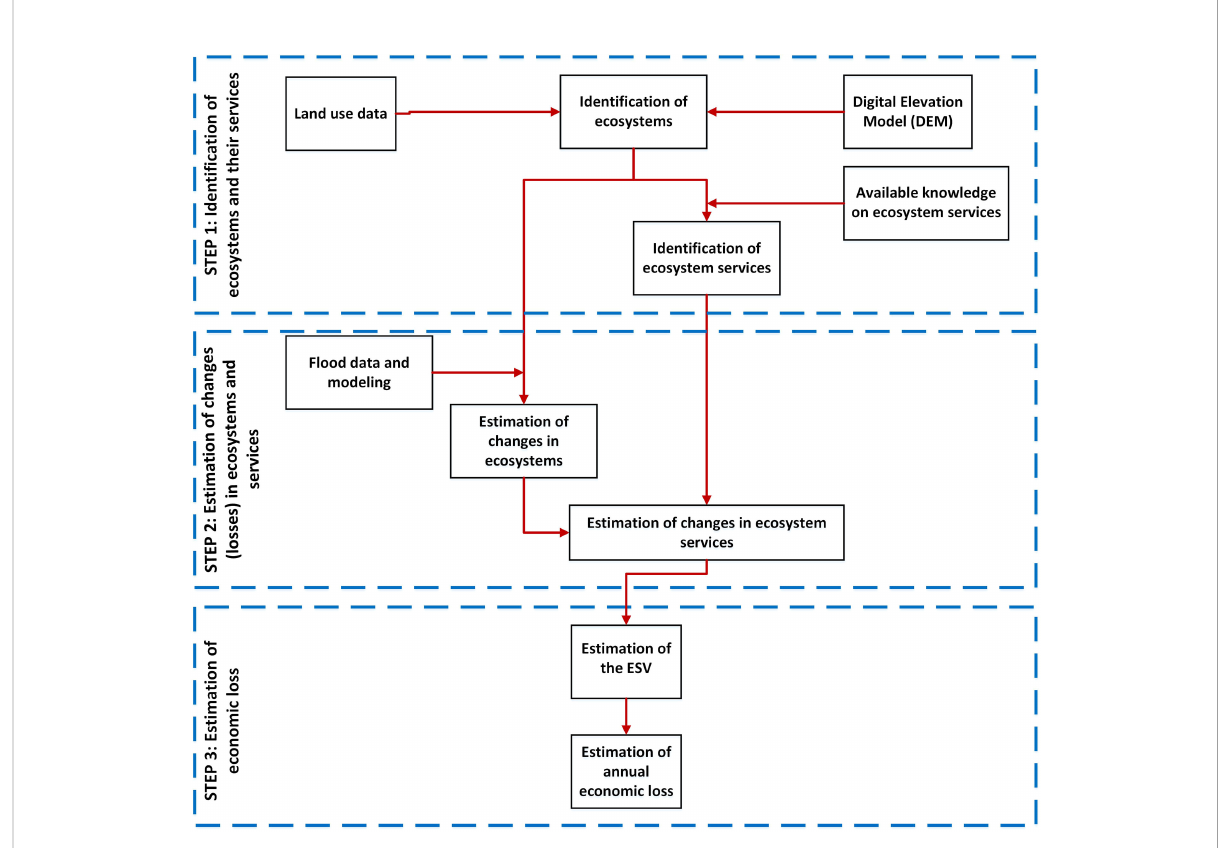
FIGURE 2 Steps of the proposed method for the estimation of economic loss for the ecosystem services